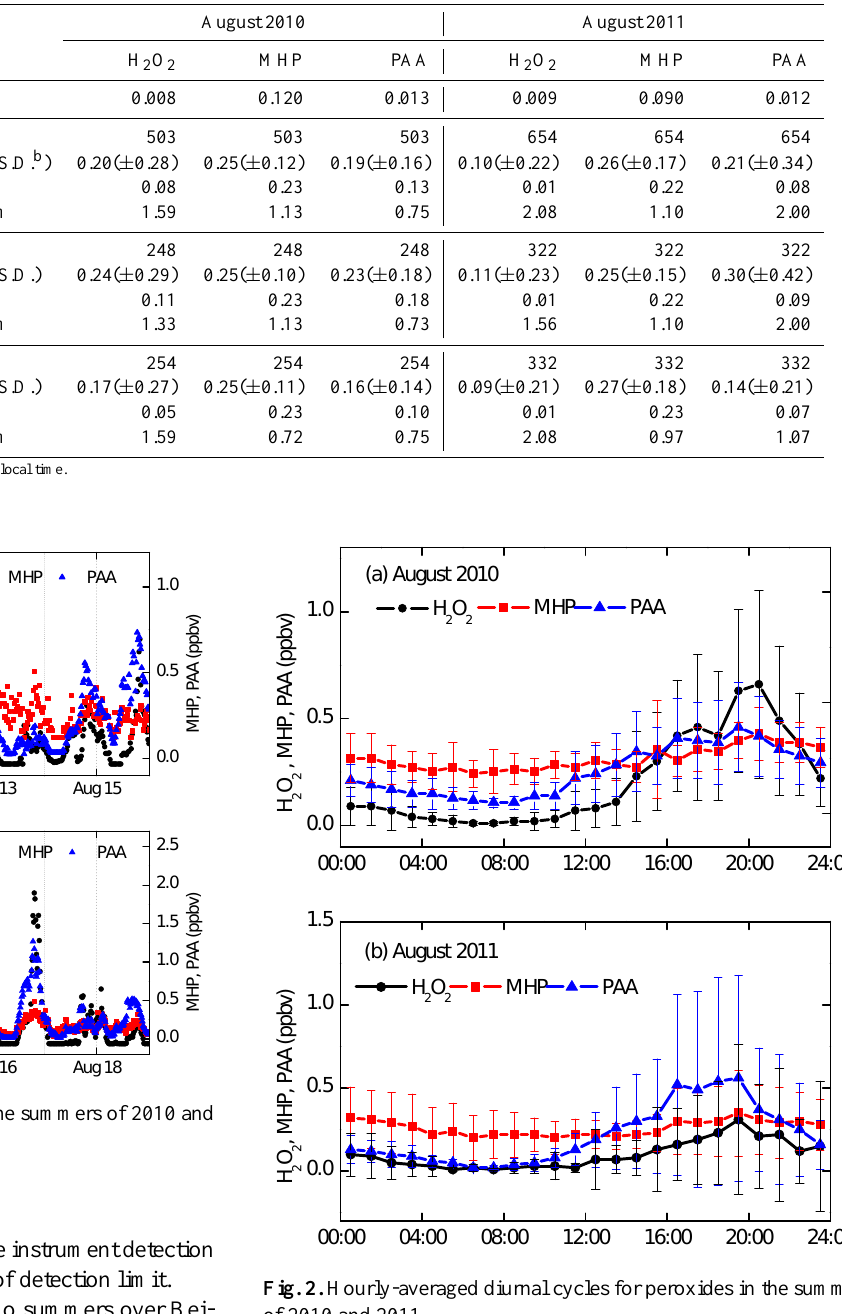
Table 1. Summary of atmospheric peroxide concentrations (ppbv) in August 2010 and August 2011, urban Beijing.